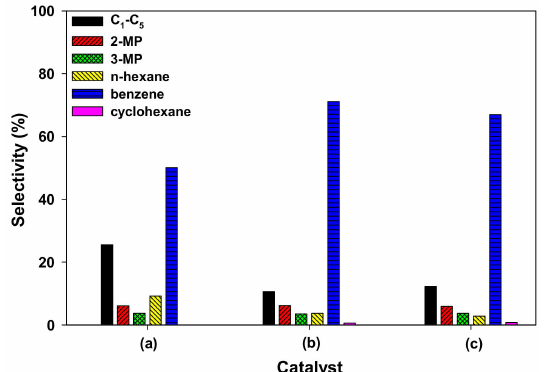
Figure 10. Product selectivity in methylcyclopentane reforming over various catalysts at a reaction temperature of 450 ◦ C. ( a ) Pt / HZSM-48, ( b ) Pt / (HZSM-48 + pseudoboehmite, 1:1), ( c ) Pt / (HZSM-48 + pseudoboehmite, 1:2) (reaction condition: H 2 / MCP (mole / mole) 10, pressure 1 atm, WHSV 0.3 h − 1 , and T-O-S 3